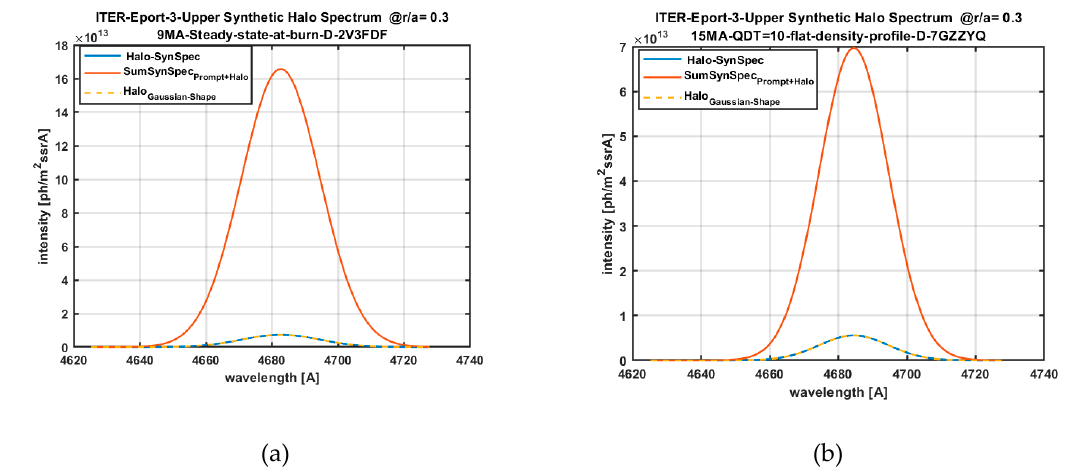
Figure 9. ( a ) Electron- and Ion-ionisation rates used for Halo model ( b) Halo and beam density profile, ITER, DNB 100keV/amu, 9MA scenario;